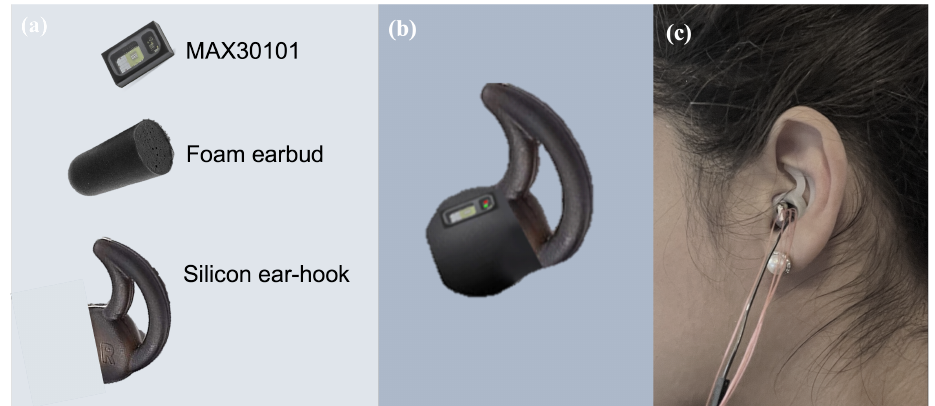
Figure 2. The in-ear PPG sensor used in our study. ( a ) The different components of the in-ear sensor. ( b ) The PPG sensor chip embedded on a viscoelastic earbud attached to an ear hook. ( c ) Sensor placement within the ear